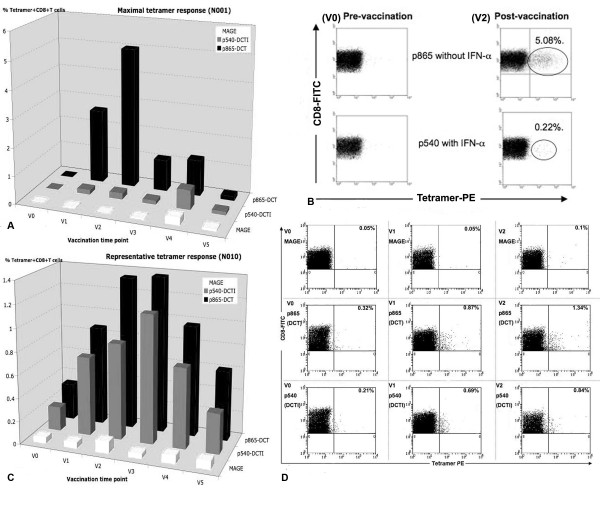
A. Maximal tetramer response (DCT vs DCTI). Time course of tetramer response to vaccination in a patient (N001) who generated the highest level of tetramer+CD8+T cells after 2 courses (V2), compared with baseline (V0). B. Flowcytometry of peak tetramer response: Tetramer flowcytometry plots for N001 at V0 and V2, 150,000 events were acquired and analysed. C. Representative tetramer response (DCT vs DCTI): Time course of tetramer responses to vaccination in a representative patient (N010) who generated equivalent tetramer+CD8+T cell responses to DCT and DCTI. D. Flowcytometry of representative tetramer response: Tetramer flowcytometry plots for N010 at V0, V1 and V2. MAGE-3 was used as the control, non-TAAg;150,000 events were acquired and analysed.